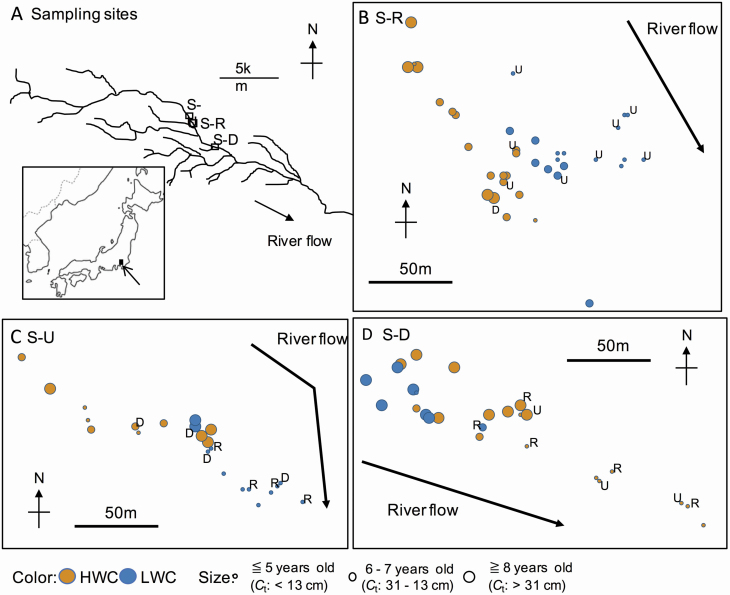
Map of the study area indicating study sites (A: all sampling sites, B: S-R, C: S-U, D: S-D). Each circle indicated the sampling location of each individual. Circle colour distinguishes subpopulation (i.e. HWC or LWC) and size stated the age of individuals. Capital letters indicated individuals assigned to other population. U = assigned to S-U, R = assigned to S-R, D = assigned to S-D.